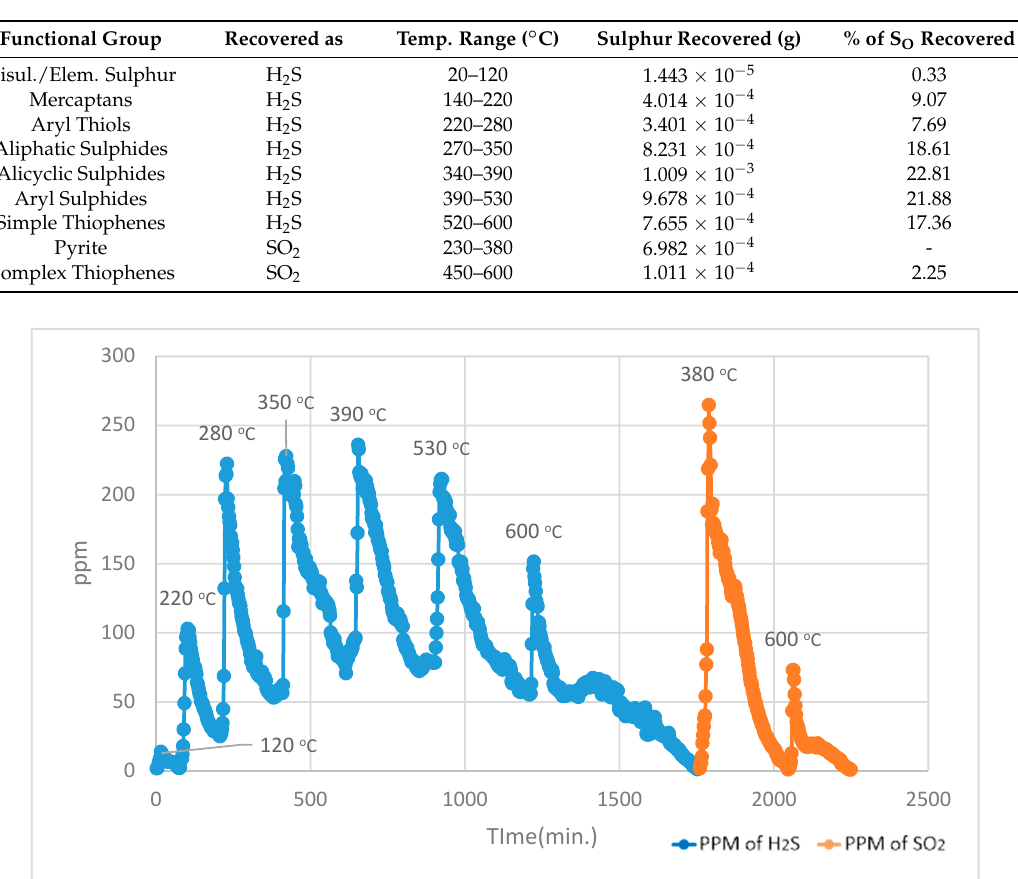
Figure 12. TPI of untreated mequinenza lignite.